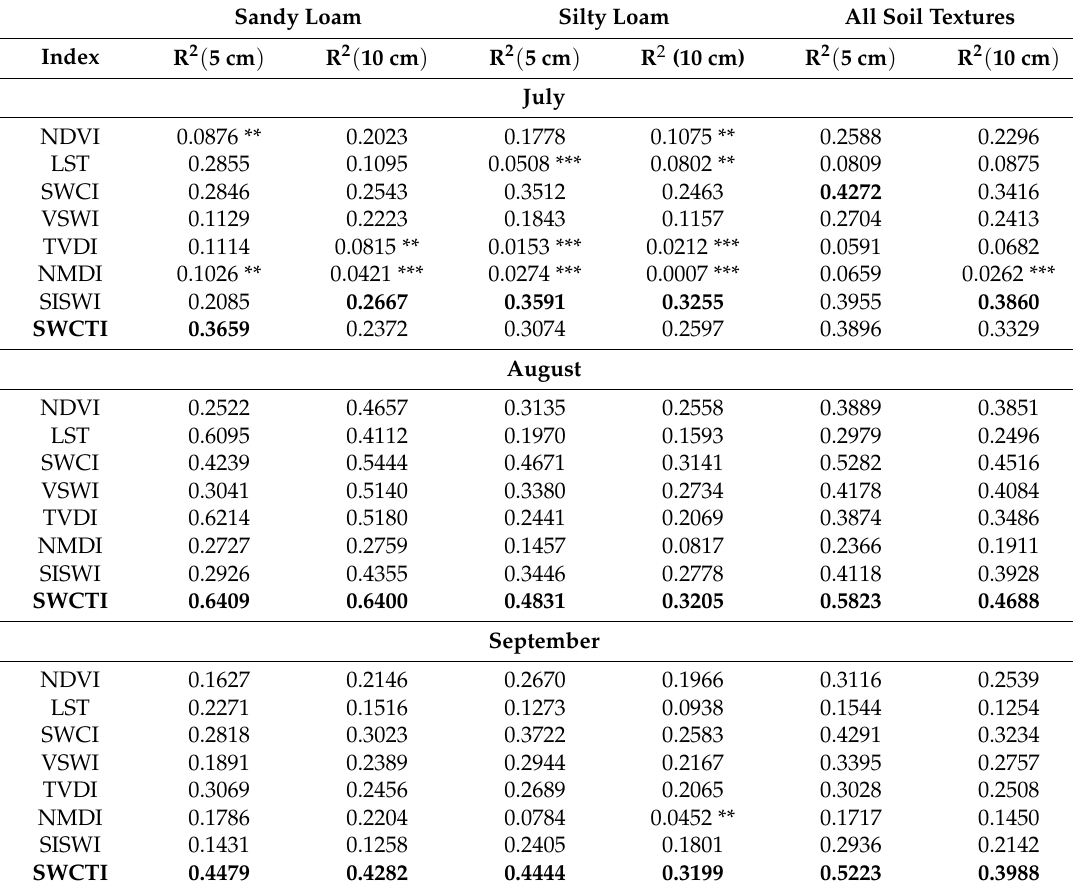
Table 3. Correlation between remote sensing indices and soil moisture at different soil depths and during different